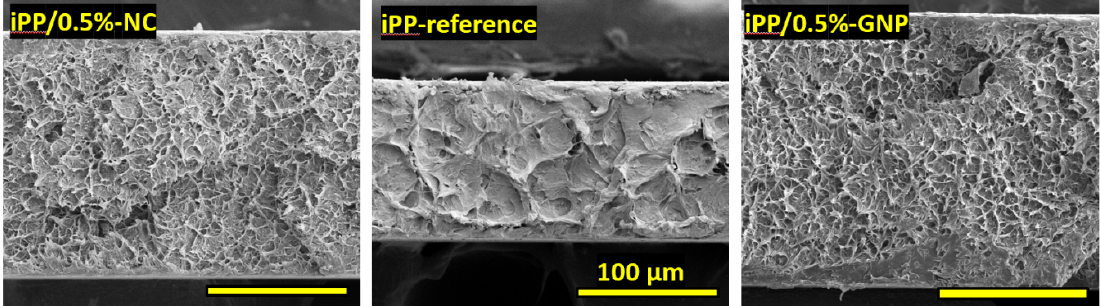
Figure 6. SEM images of cross sections of the fracture surfaces, demonstrating significant levels of roughness.